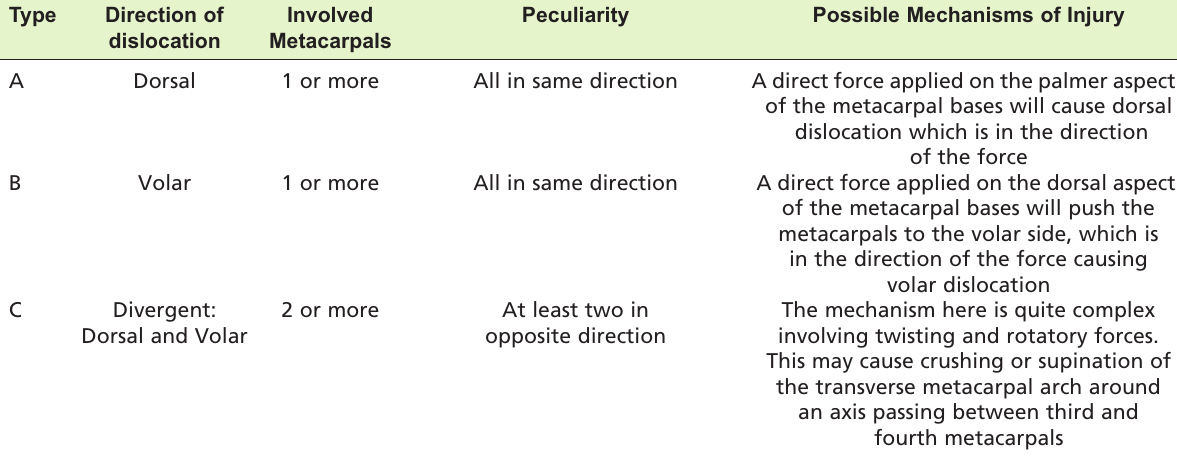
Proposed category of mechanisms of CMC Table III: